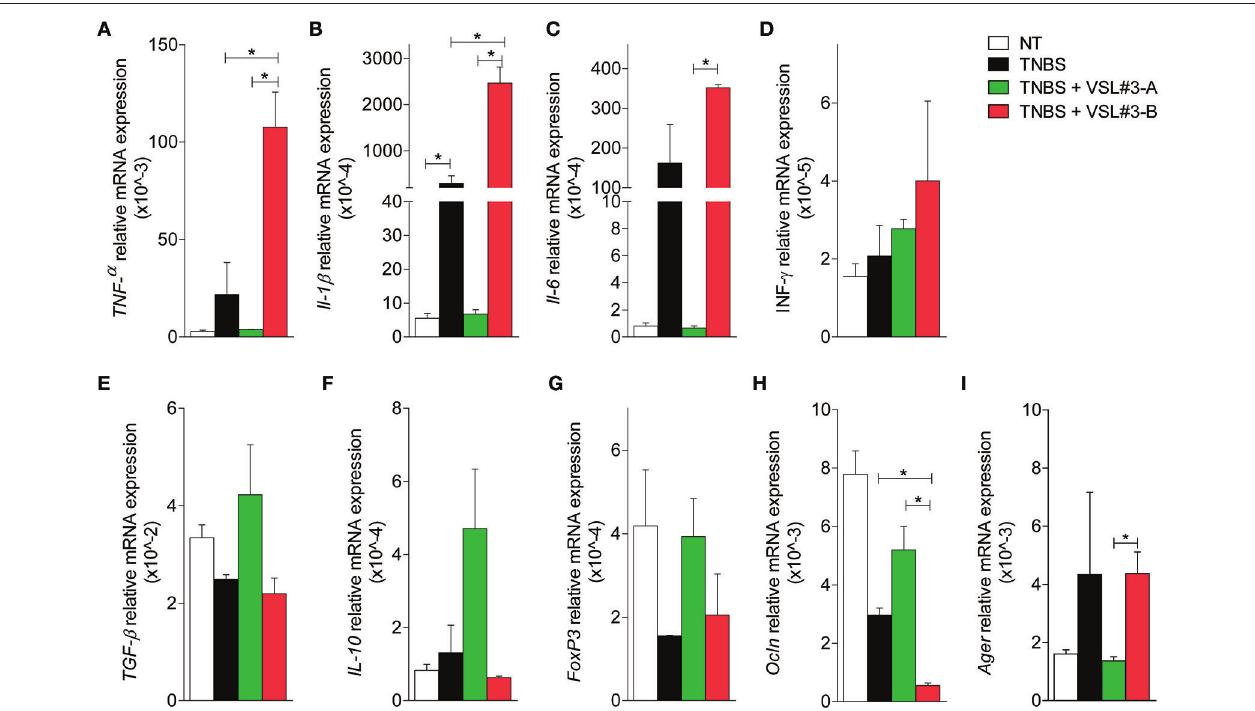
FIGURE 3 | Effects of two VSL#3 preparations on biomarkers of intestinal inflammation in the TNBS colitis. Quantitative rtPCR analysis of pro-inflammatory genes TNF- α , IL-1 β , IL-6 and IFN- γ (A–D), anti-inflammatory genes, TGF- β , IL-10, and FoxP3 (E–G) , occludin (H) , and Ager (I) . Results are the mean ± SEM of 4–7 mice per group (* P < 0.05).